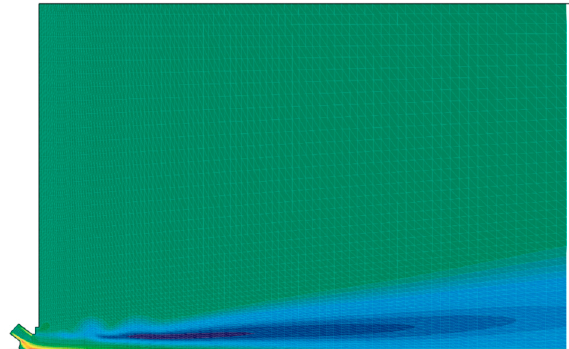
' ' u u of the flow with non-swirling atomizing air. Figure 9. x y Figure 9. u (cid:48) x u (cid:48) y of the flow with non-swirling atomizing air. Figure 9. of the flow with non-swirling atomizing air.